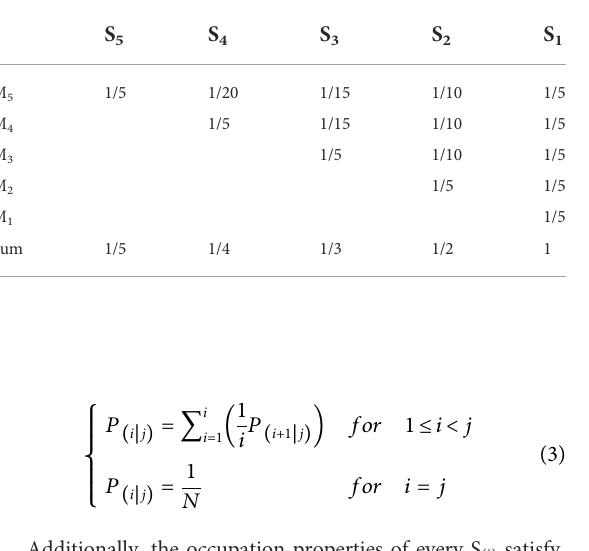
TABLE 2 Occupation properties of every